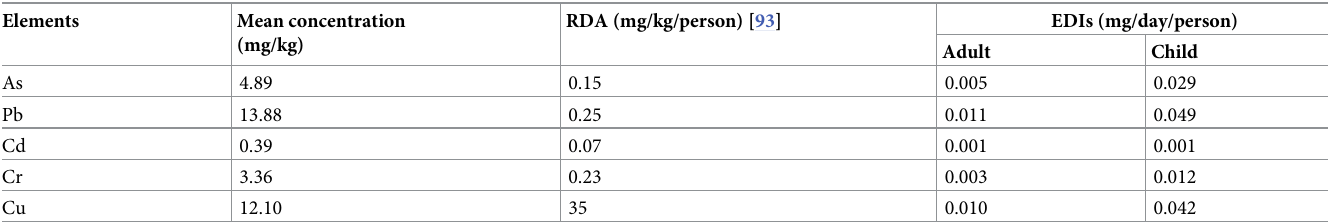
Table 5. A comparison between recommended daily allowance (RDA) and estimated daily intake (EDI) for adults and children. Elements Mean concentration